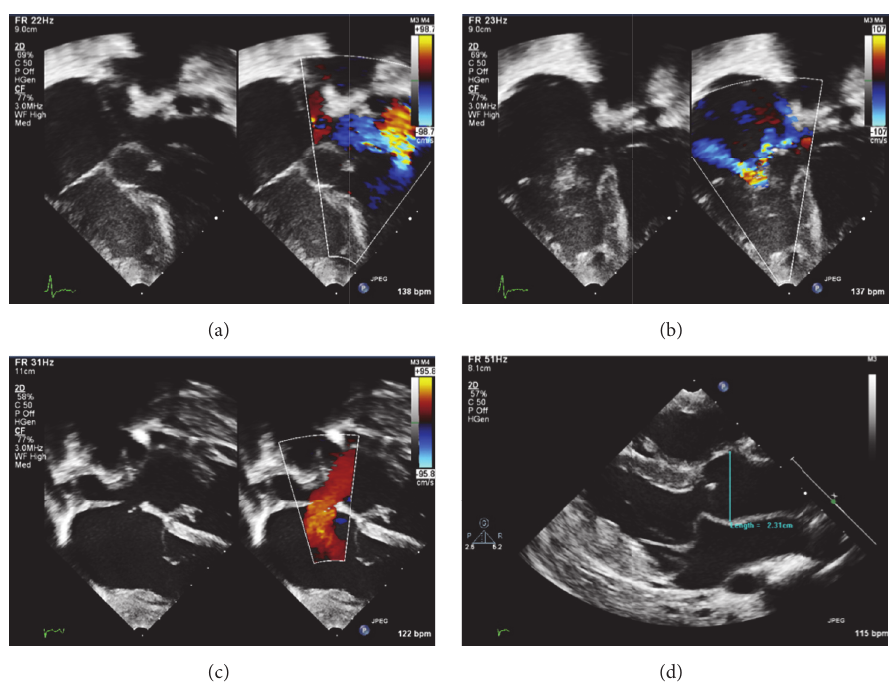
Figure 2: Presurgical echocardiographic features of the proband: (a) apical 4-chamber view demonstrating mitral regurgitation. (b) Apical 4-chamber view demonstrating tricuspid regurgitation. (c) Subcostal 4-chamber view demonstrating atrial septal defect. (d) Parasternal long axis view demonstrating mitral valve prolapse and aortic root dilatation.